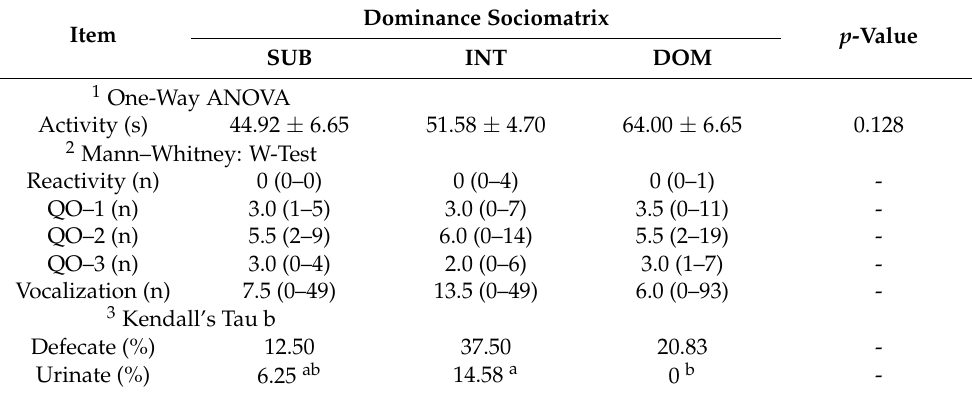
Table 6. Data from open field test according to the dominance sociomatrix of finishing pigs.